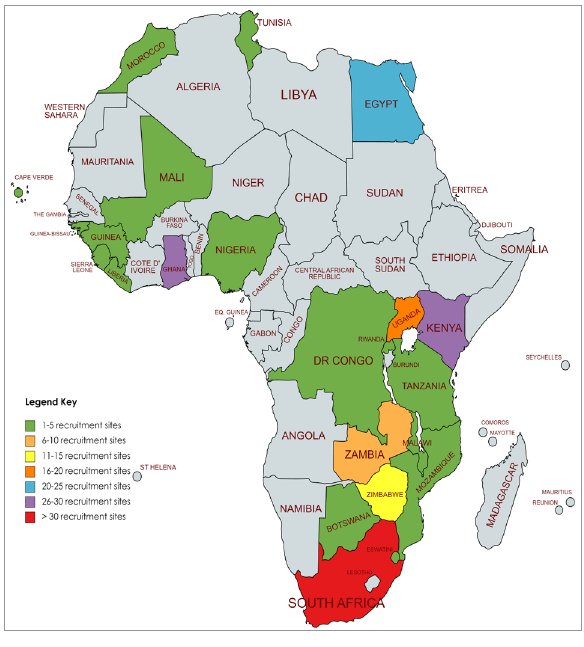
Figure 2: Location of recruitment centres of COVID-19 vaccine trials in Africa. The principal investigators were based in African countries in 76 (70%) trials and outside Africa in 14 (13%) of the trials. In 18 (17%) trials, the location of the principal investigator was not provided. A small proportion (15%, n =16) of the trials had a summary of the results in the registry record. The funding for the trials came from industry in 30% ( n =39), charities and foundations in 13% ( n =14), non-industry funding agencies in 7% ( n =9), universities in 6% ( n =8), and governmental bodies in 5% ( n =6) of the 108 trials. Similarly, the trial sponsors were from industry in 54% ( n =67), universities in 20% ( n =24), charities and foundations in 13% ( n =14), professional societies in 6% ( n =7), and non-industry funding agencies in 5% ( n =6) of trials. Trials were sponsored from the African country where recruitment took place in 27% ( n =29) and funded from the recruitment country in 16% ( n =17) of the trials. Most sponsors (21%; n =23) and funders (19%; n =21) were from the United States of America. Other countries that sponsored five or more trials include China (13%; n =14), the Netherlands (8%; n =9), the United Kingdom (7%; n =8), and Germany (7%; n =8). Similarly, countries that funded five or more trials include China (10%; n =11), the United Kingdom (6%; n =6), and the Netherlands (5%; n =5). On 19 May 2022, we found 1453 non-duplicate COVID-19 vaccine trial records in the ICTRP; only 108 (7%) of which had at least one recruitment site on the African